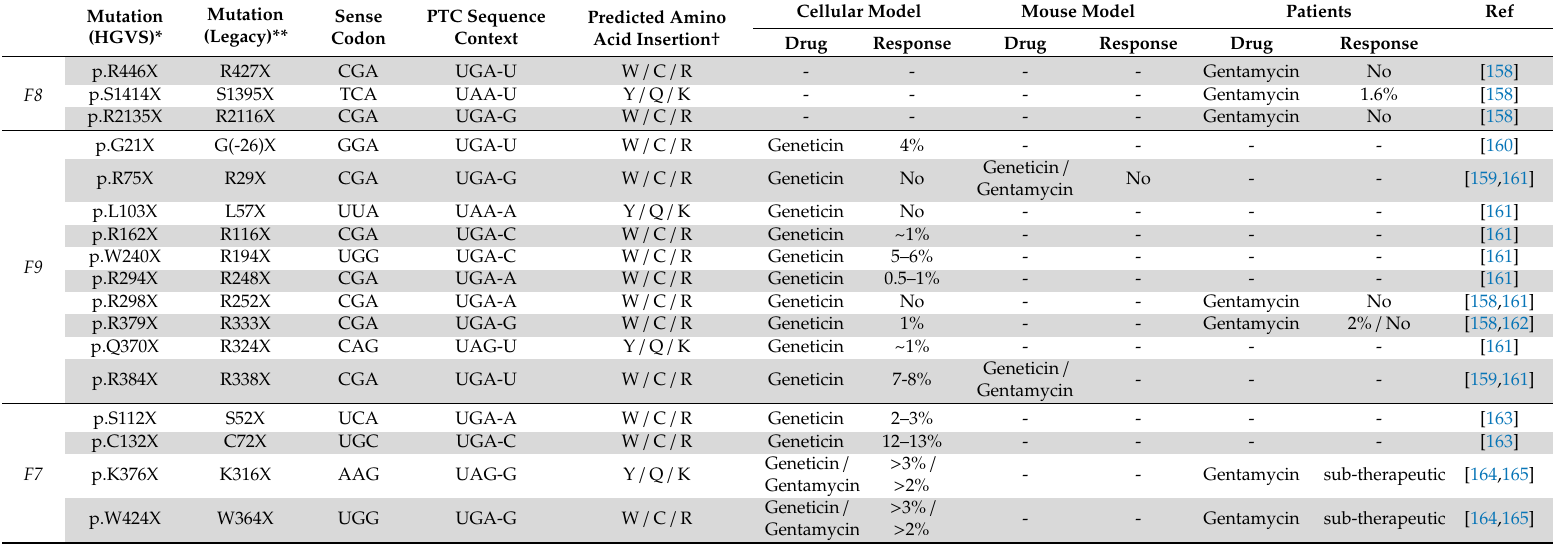
Table 2. Evaluation of drug-induced readthrough over nonsense mutations in FVIII, FIX and FVII